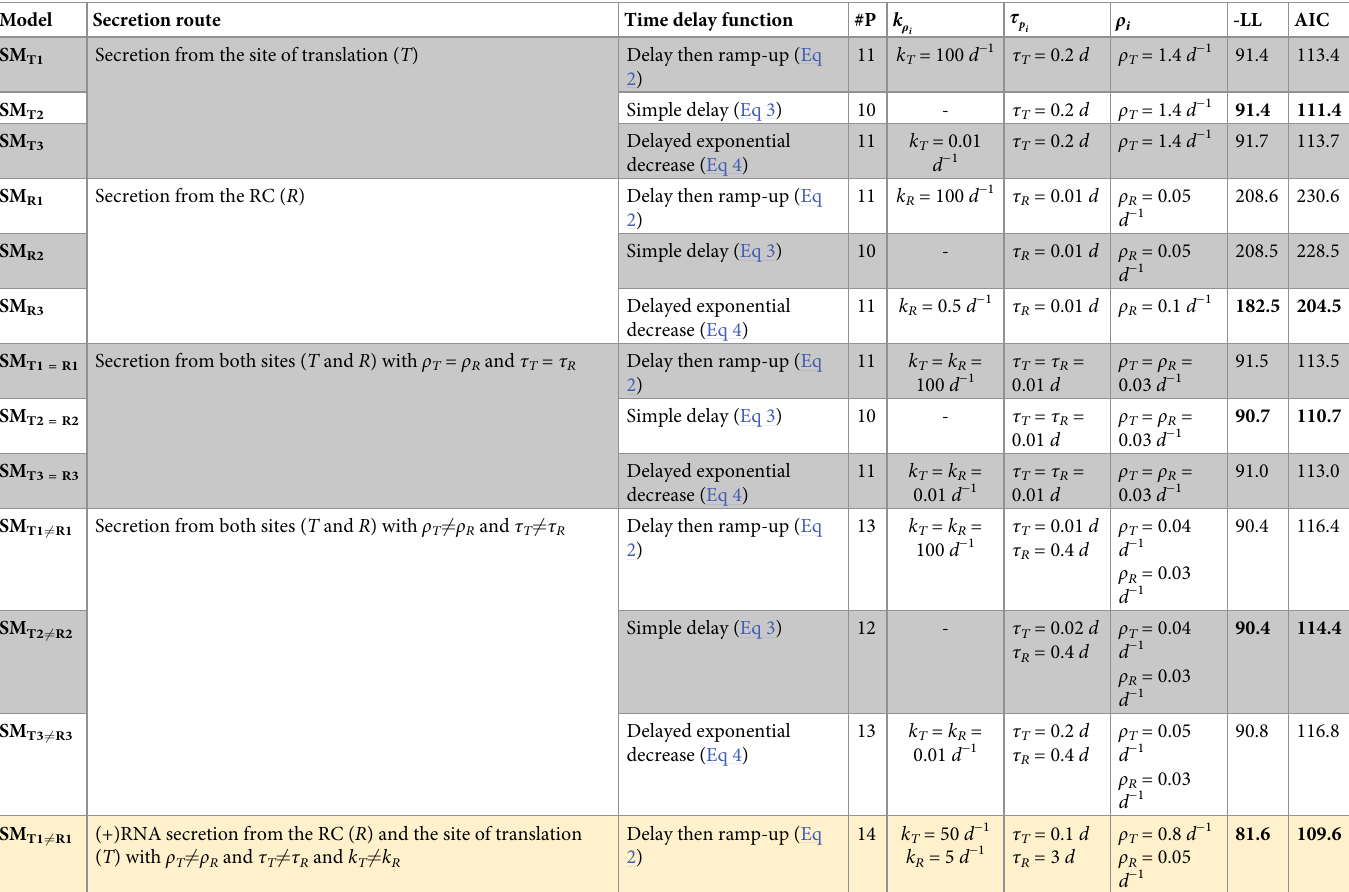
Table 3. Model comparison of the SM models. Negative log likelihood (-LL), AICs, number of estimated model parameters (#P), and k SM T1 to SM TR3 , which were fitted to measurements of plus-strand RNA, minus-strand RNA, and secreted HCV RNA in Keum et al. [35]. The model with the lowest AIC is highlighted in beige and the lowest AIC for each model variant is shown in